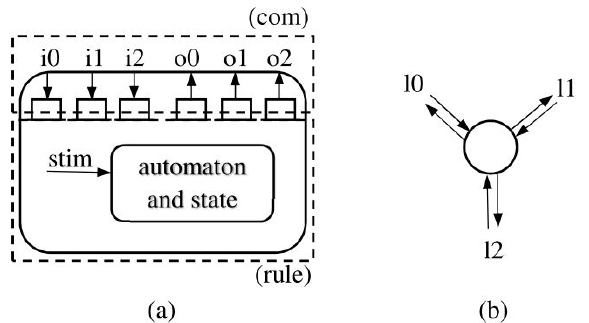
Figure 12. Cell node representation: ( a ) is the internal architecture with an automaton ( rule ) operating on incoming values and local stimuli ( stim ), based on a local set of variables, filling output communication buffers. Communications ( com ) are operated to and from the input and output buffers; ( b ) is the external point of view that only shows bidirectional links of a cell